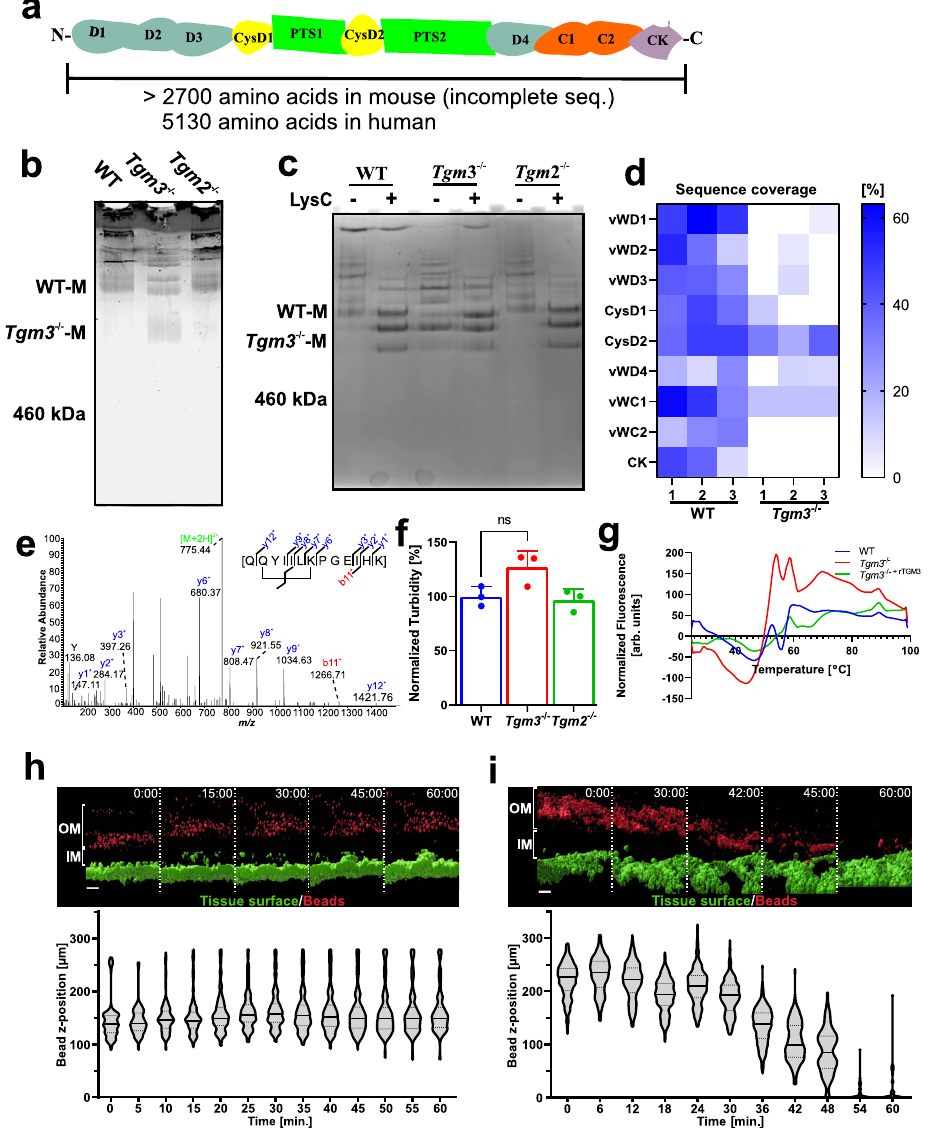
Fig. 3 Loss of TGM3 causes biochemical alterations of MUC2 and mucus. a Schematic fi gure of human and mouse MUC2. Protein domains excluding the signal sequence are shown. Abbreviations correspond to vWD, von-Willebrand D; CysD, cysteine-rich domain; PTS, Proline-Serine-Threonine rich becomes mucin domain after O- glycosylation; vWC, von-Willebrand C; CK, Cystine Knot. b MUC2 mono- and oligomers from WT, Tgm2 − / − and Tgm3 − / − colonic mucus separated by composite AgPAGE and stained by in-gel immunodetection ( n = 3). c Limited proteolysis of MUC2 by Lys-C. Mucus was incubated in the absence or presence of Lys-C followed by composite AgPAGE analysis and staining with Alcian blue ( n = 3). d MUC2 sequence coverage. MUC2 domains are organized from the N- to C-terminus on the ordinate. The PTS domains were excluded as they cannot be analyzed due to their glycosylation heterogeneity. Non-treated MUC2 monomers (WT-M and Tgm3 − / − -M) as indicated in ( c ) were analyzed by MS and sequence coverage color-coded ( n = 3). Source data are provided as a source data fi le. e Detection of transglutaminase reaction products. Example of an intramolecular isopeptide cross-link solely detected in MUC2 from WT animals. MS2 fragment spectrum of the parent ion [M + 2H] 2 + 775.44 is shown. B-ions are labeled red and y-ions blue. The parent ion is labeled green. f Analysis of MUC2 polymerization. Following precipitation of insoluble MUC2 by centrifugation the absorbance of soluble material was recorded at 600 nm. ( n = 3). Data are presented as mean ± standard deviation. A two-sided t-test between WT and Tgm3 − / − samples was performed p = 0.0738. g Analysis of mucus hydrophobicity. Melting curves were recorded as described in the methods section. Graph shows the mean of three animals per strain. h , i Pronase treatment of colon explant from WT ( h ) and Tgm3 − / − ( i ) mice. Explants were mounted in perfusion chamber (Fig. 2e) and treated with pronase. Mucus surface was visualized by addition of fl uorescently labeled beads, epithelium was counterstained with Syto9. The upper panels show isosurfaces of tissue (green) and beads (red) over time. Lower panel shows the distribution of beads in relation to tissue over time as violin plot. Black bars represent median bead position. Dashed lines represent the 25% quartile. n = 3. (Scale bars = 50 µ m; OM = outer mucus; IM = inner